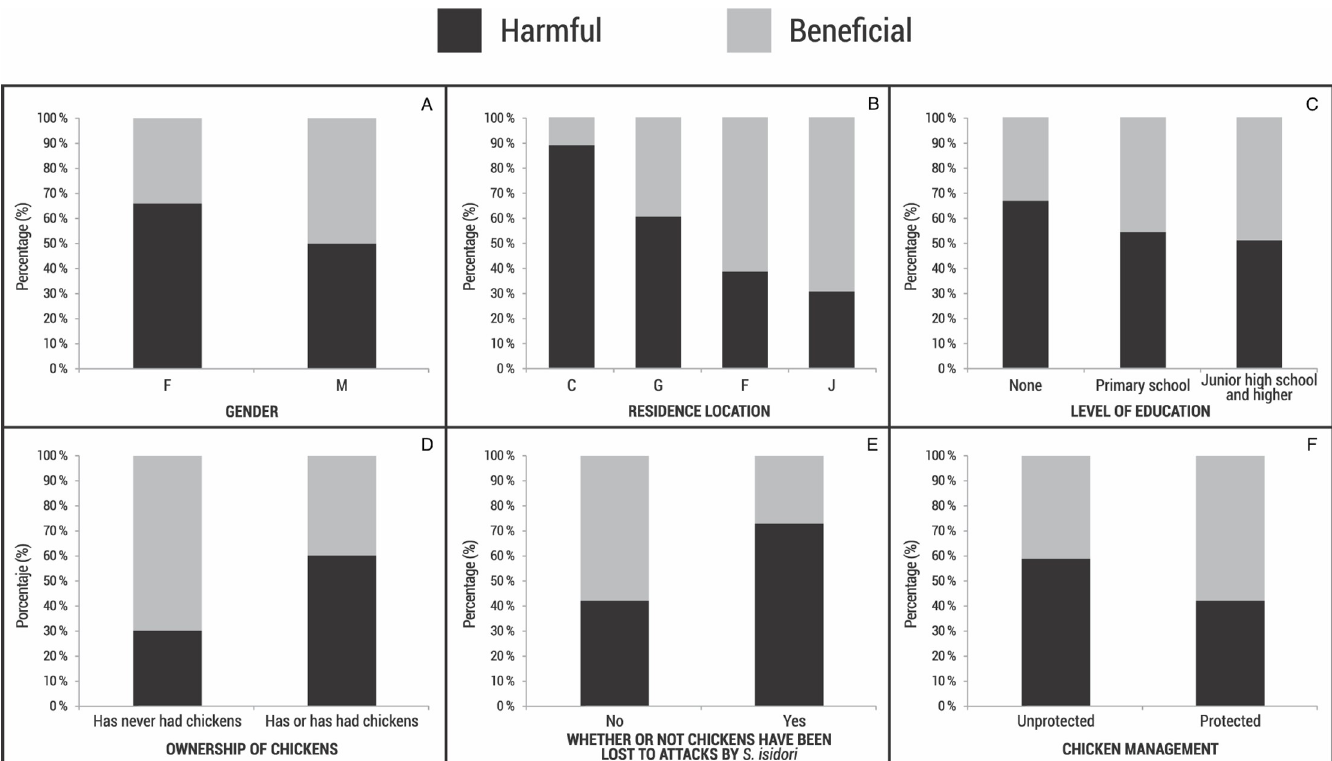
Fig 1. Profiles of the perception of Spizaetus isidori by people in Colombia. A) Gender (F: Female; M: Male), B) Residence location (C: Campohermoso; G: Gigante; F: Fo´meque; J: Jardı´n), C) Level of education, D) Ownership of chickens, E) Whether or not chickens have been lost to attacks by S . isidori , and F) Chicken management (Unprotected: chickens are not kept in coops or protected from aerial attack; Protected: chickens are kept in coops that protect them from aerial predators).